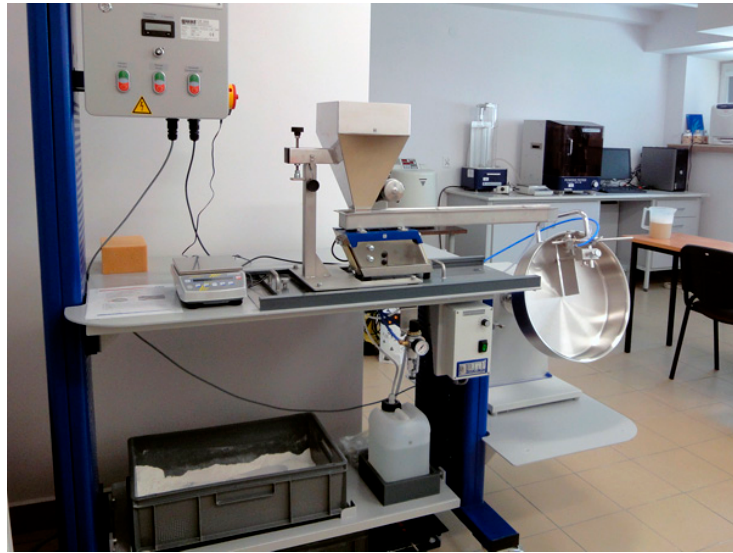
Figure 3. Pilot-scale pan granulator used for the